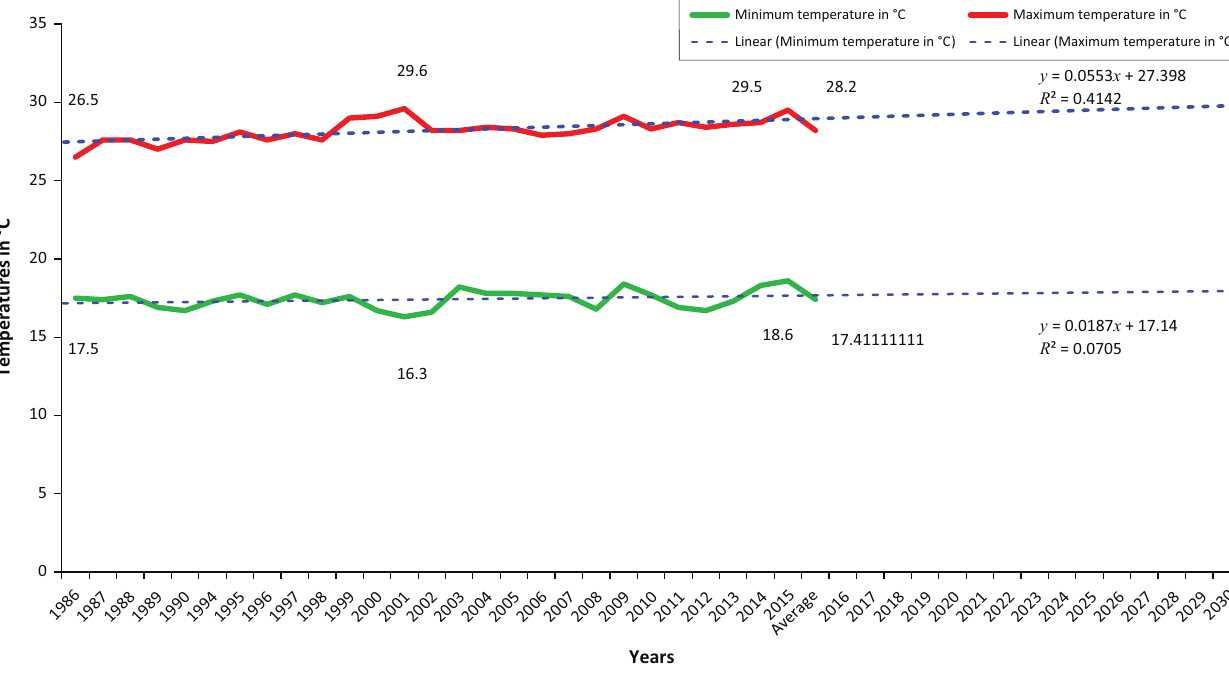
Source: National Meteorology Institute of Ethiopia (NMIE), 2015, Secondary data of precipitation and temperatures from 1986 to 2015 . National Meteorology Institute of Ethiopia (NMIE), Addis Ababa. FIGURE 3: Konso annual average maximum and minimum temperatures (°C) for period 1986-2015 and projection up to